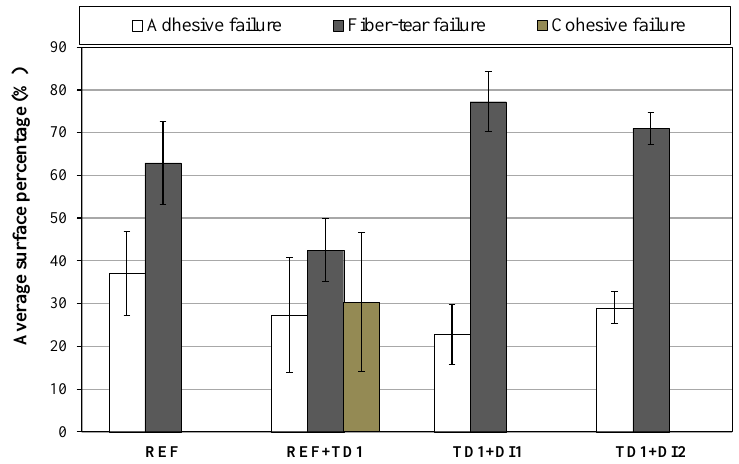
Figure 8. Average percentages of the failure modes presented in the tensile tested scarfed joints, sorted according to the contamination scenario.